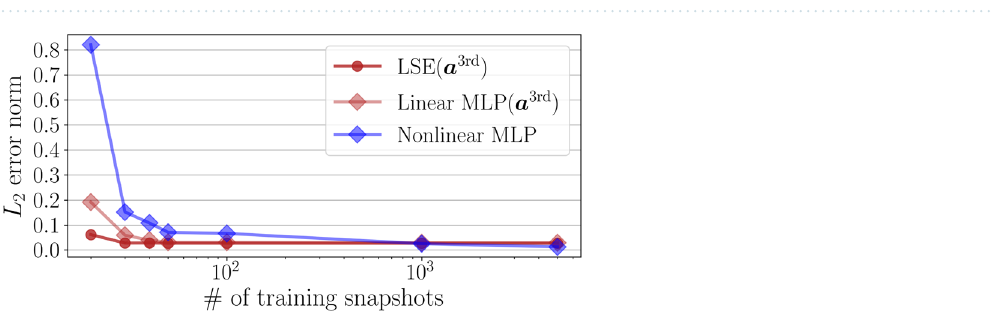
Figure 3. Dependence of the L 2 error norm for the POD coefficient estimation on the number of training